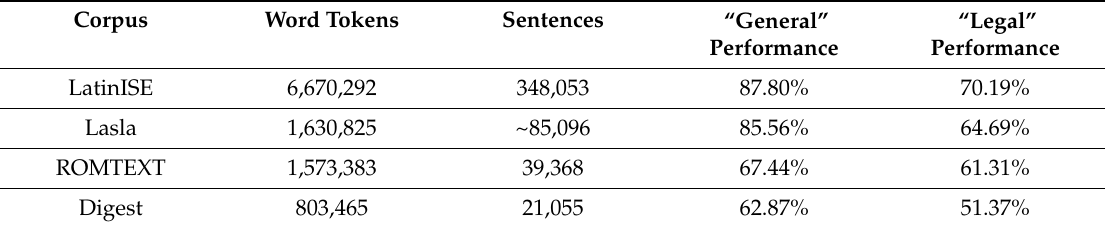
Table 1. Main characteristics of the four Latin corpora and the performance scores of their fastText word embeddings models on the general and adapted legal